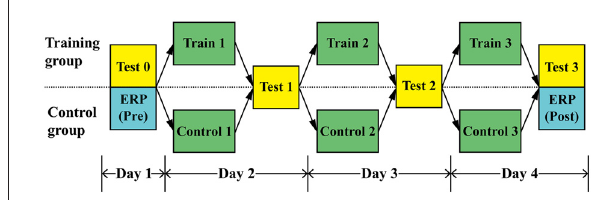
FIGURE 1 | Phases in the experimental design for the training and control